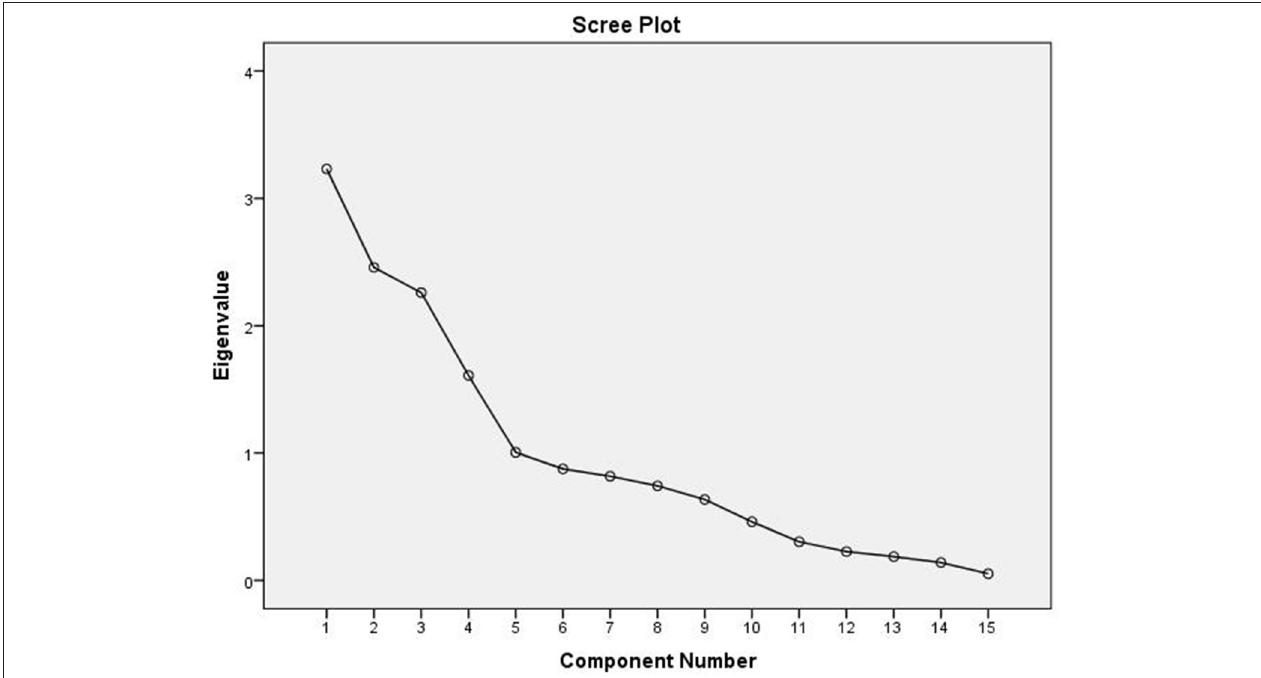
FIGURE 2 | Hirerchial clustering based of native maize germplasm using wards’